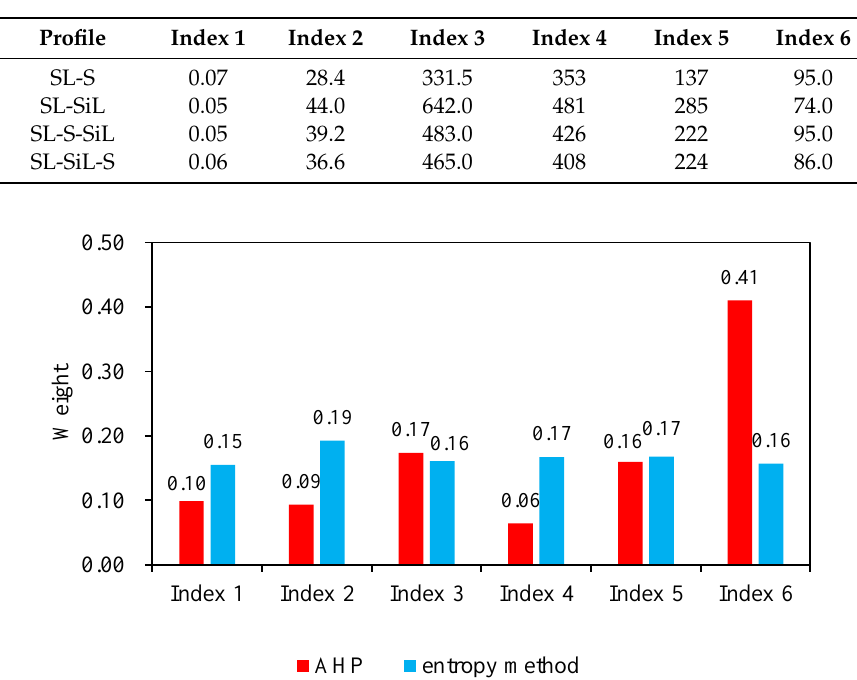
Table 8. Evaluation indices of different soil profiles.